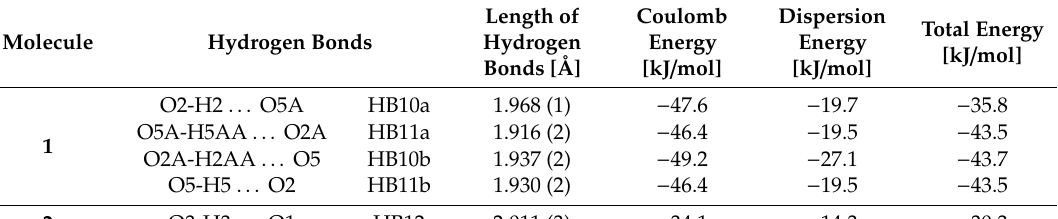
Figure 4. Infinite hydrogen bond motifs in the crystal structures of (a) 1 , (b) 2 , and (c) 3 . The hydrogen atoms were omitted for clarity.